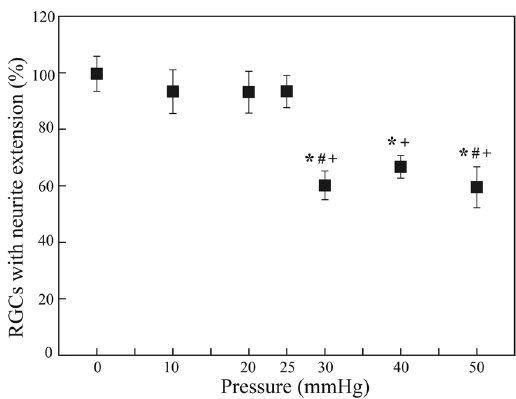
Figure 3. The proportion of RGCs with neurite extensions (%) 3 days after applying a hydrostatic pressure of 0 mmHg (n = 22 devices, n 0,RGCs = 993), 10 mmHg (n = 4 devices, n 0,RGCs = 106), 20 mmHg (n = 6 devices, n 0,RGCs = 534), 25 mmHg (n = 7 devices, n 0,RGCs = 503), 30 mmHg (n = 11 devices, n 0,RGCs = 552), 40 mmHg (n = 9 devices, n 0,RGCs = 370), and 50 mmHg (n = 11 devices, n 0,RGCs = 432 RGCs) for 72 hours. Data are in mean ± SEM. * , # and + indicate statistically different results from 0 mmHg (P < 0.05), 10 mmHg (P < 0.05), and 20 mmHg (P < 0.05) respectively by one-way ANOVA followed by Bonferroni post-hoc test. N 0,RGCs represents the number of RGCs with neurite extensions at the